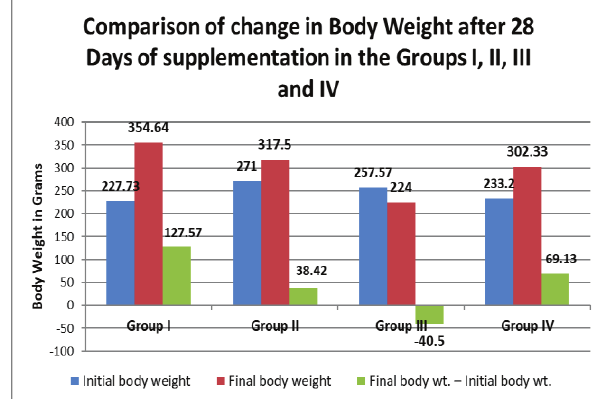
Fig-3: Comparison of Change in Body Weight after 28 Days of supplementation in the Groups, I (Diabetic Control), II (Cane Sugar), III (Honey), and IV (Jaggery). a Values are given as mean ± SD for normally distributed variables and median (IQR) for non-normally distributed variables. b p-value is generated by Paired Samples t-test. c p-value is generated by Wilcoxon Matched-Pairs Signed-Ranks Test. (p=0.001 is considered highly significant and p˂0.05 is considered